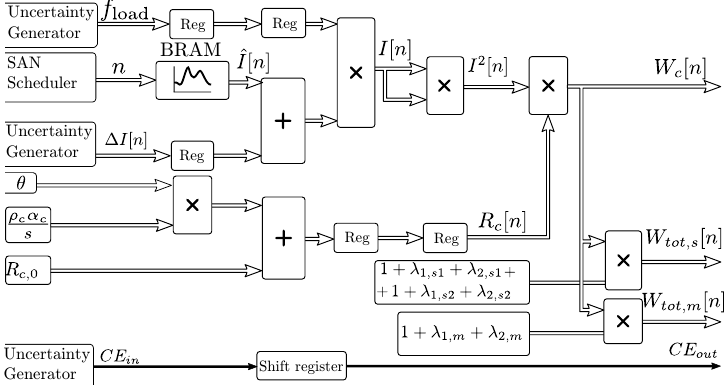
Figure 12. Pipelined input power sequence generation